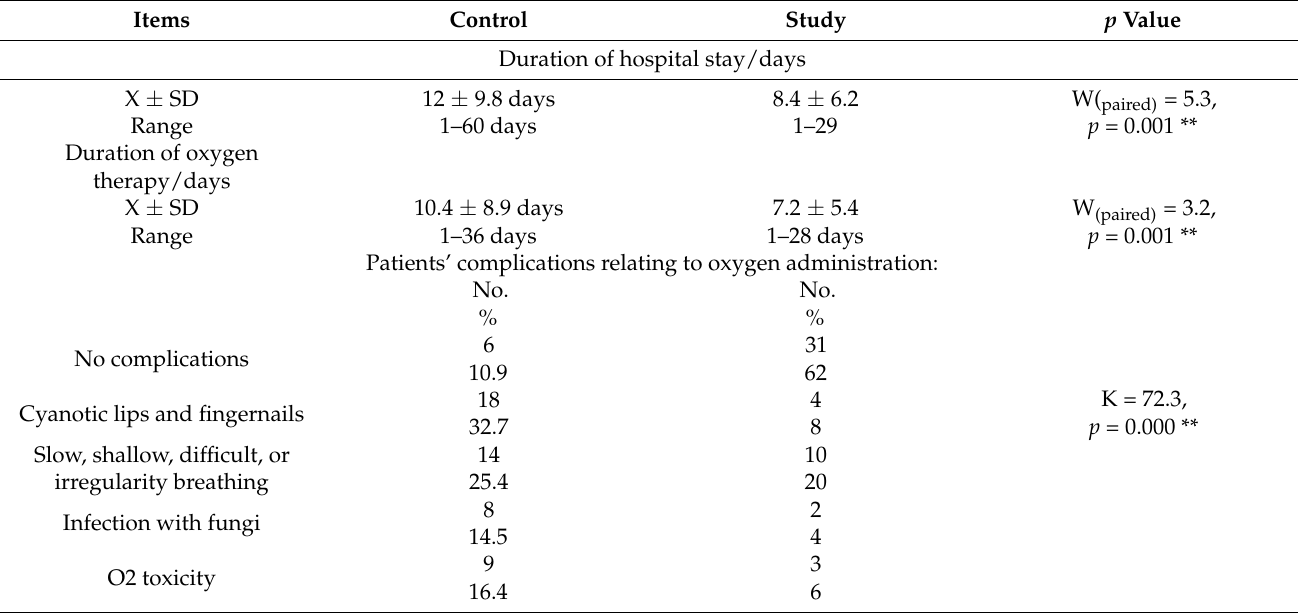
Table 3. The effectiveness of standardized protocol for oxygen medical aid on patients’ health outcomes.